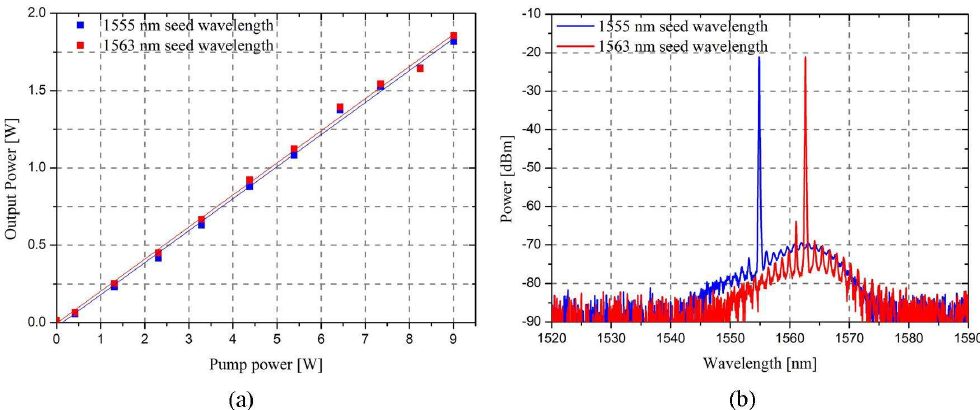
Figure 2. Characteristics of signal output power versus pump power ( a ) and optical spectra at the seed wavelength of 1555 nm and 1563 nm ( b ) recorded at the output of the second medium-power amplifier MOPA stage.